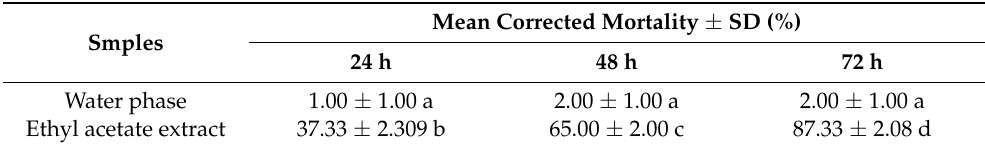
Table 2. The nematicidal activity of the aqueous phase and the ethyl acetate extract of the M4 strain culture for 72h.